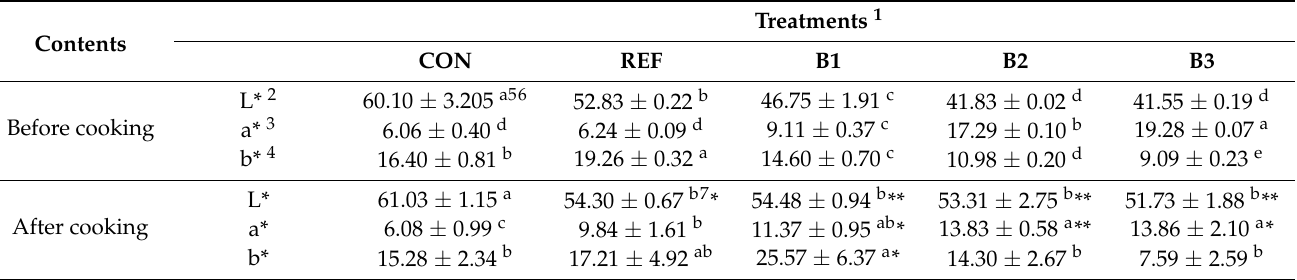
Table 7. Chromaticity of Tteokgalbi prepared with watermelon radish powder, before and after